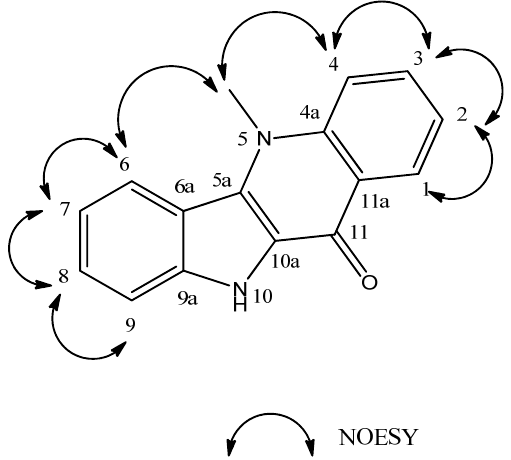
Figure 2. NOESY correlations of compound 8